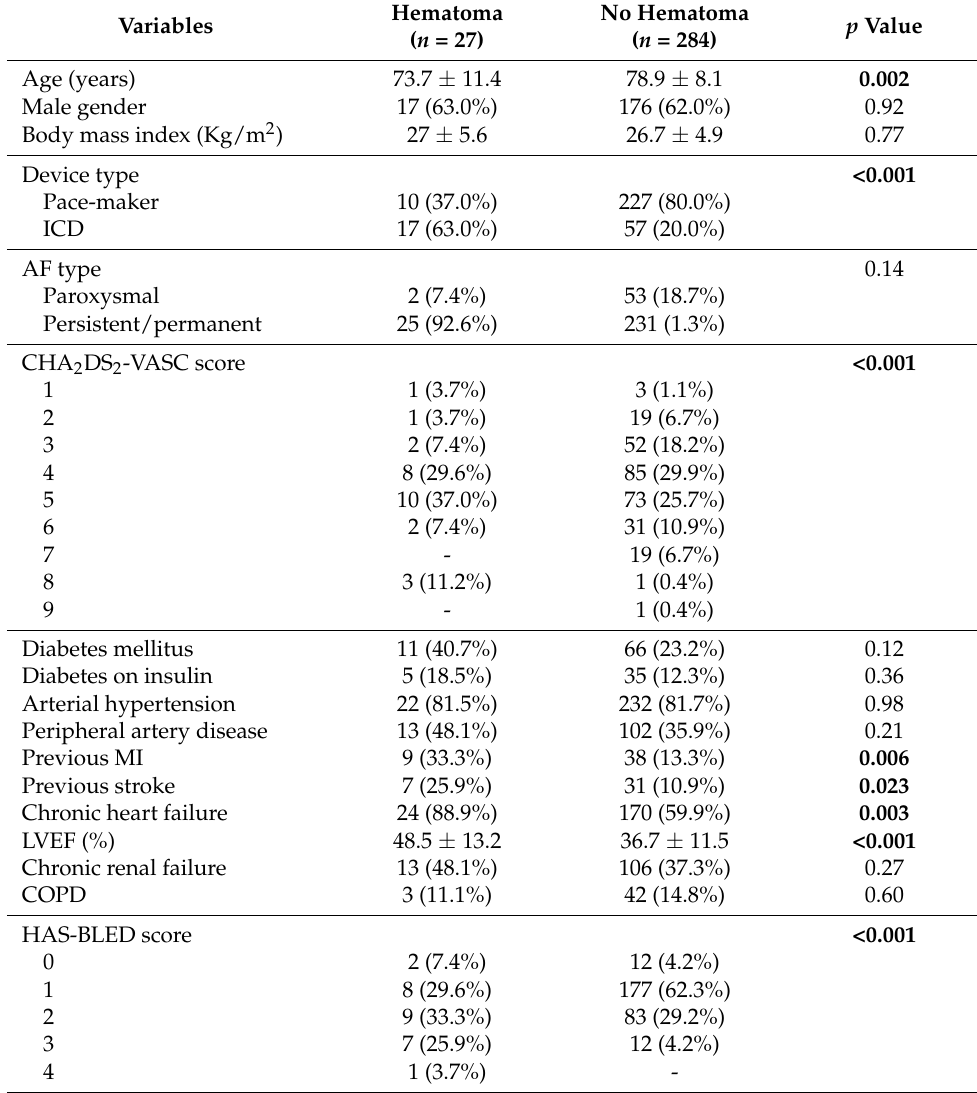
Table 3. Main demographic/clinical and laboratory data in patients with vs. without post-procedural pocket